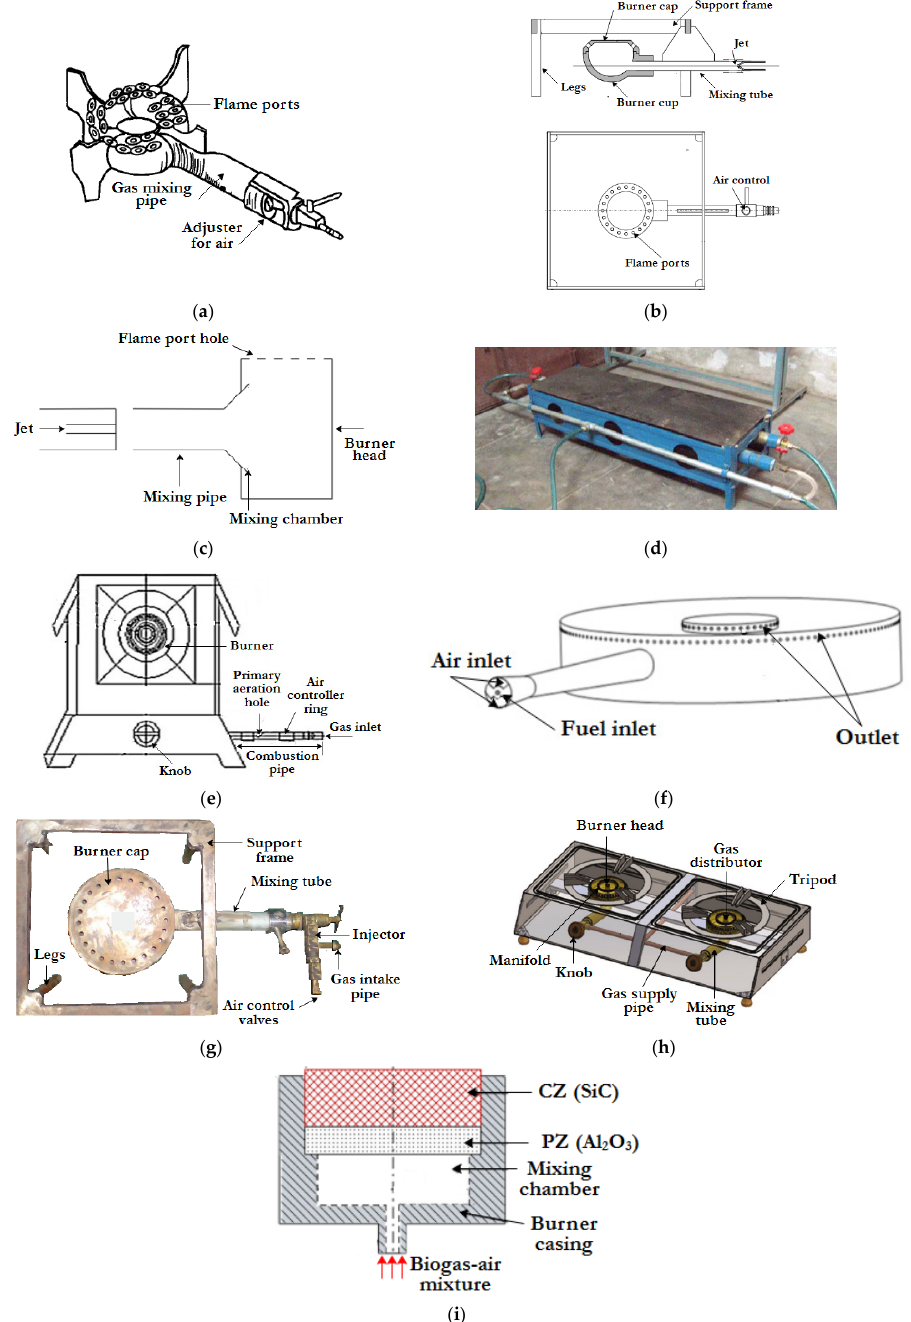
Figure 9. Biogas cook-stoves. ( a ) Biogas stove-KVIC model [55]; ( b ) DCS burner used in Nepal [50]; ( c ) Biogas stove designed by Itodo et al. [56]; ( d ) Biogas stove for baking developed by Kurchania et al. [53]; ( e ) Domestic biogas stove developed by Kurchania et al. [54]; ( f ) Biogas Injera baking burner [58]; ( g ) Biogas burner (Stove) developed by Awulu et al. [60]; ( h ) Biogas burner developed by Petro